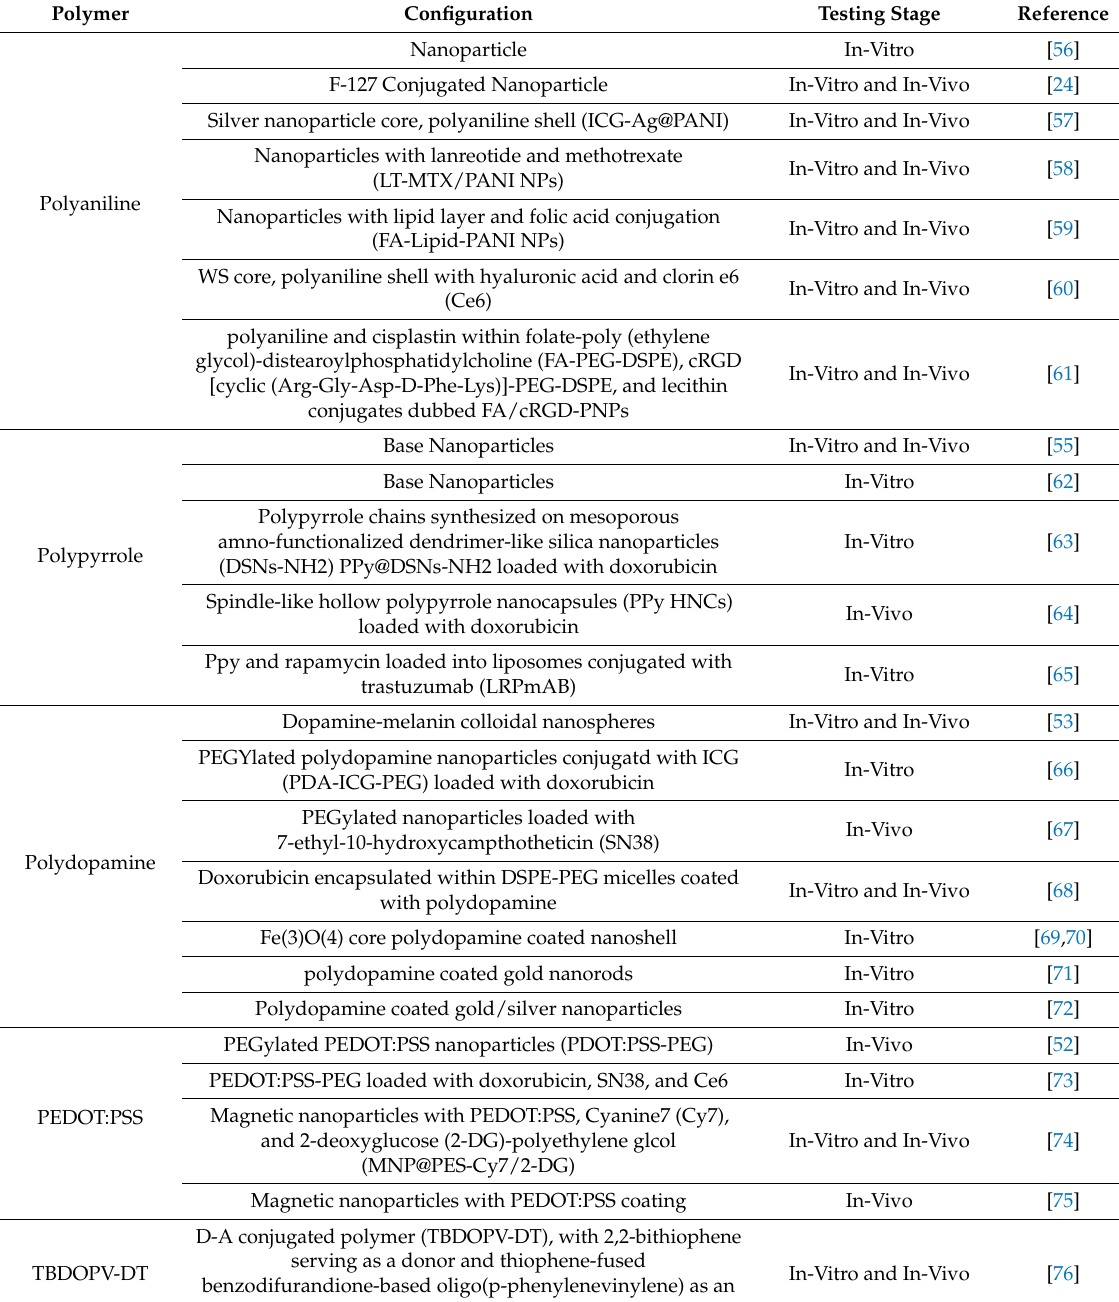
Table 1. Summary of Polymer Based Nanoparticle Systems for Photothermal